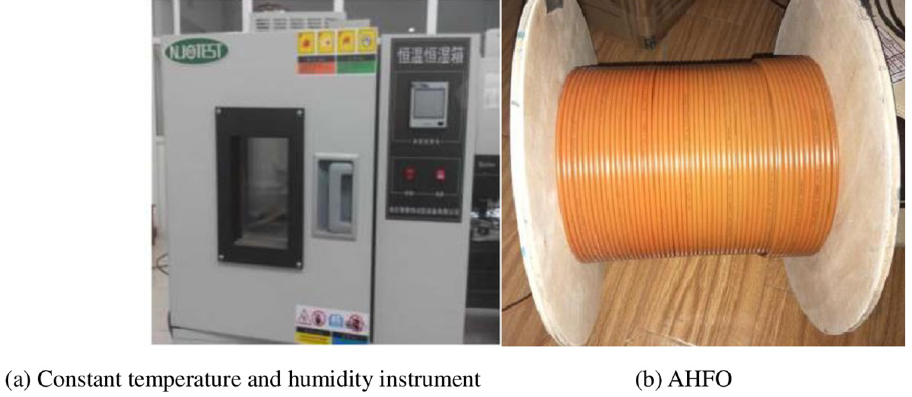
Fig 4. Optical fiber repeatability test. (a) Constant temperature and humidity instrument. (b)